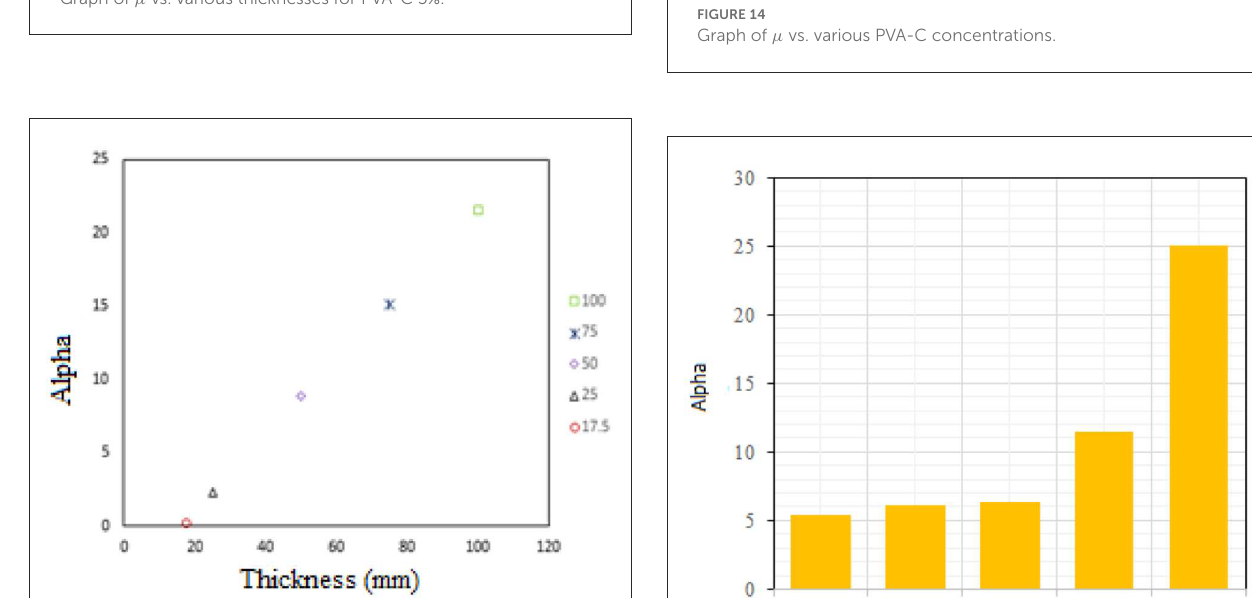
FIGURE12 Graph of µ vs. various thicknesses for PVA-C 5%.